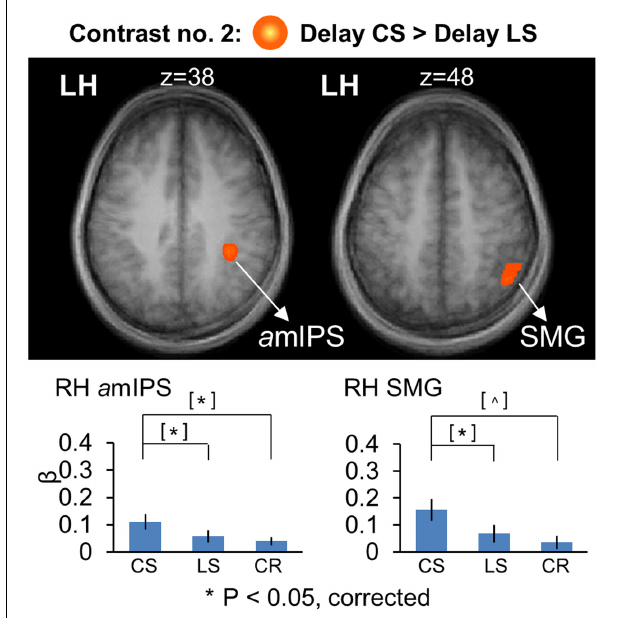
FIGURE 5 | Voxelwise statistical map obtained with the RFX GLM and activation levels for each area using Contrast no. 2 [Delay CS > Delay LS]. Top panel: activation map overlaid on the averaged anatomical image from all participants. Bottom panel: bar graphs show the β weights for the three tasks in each area. Legends as in Figure 2